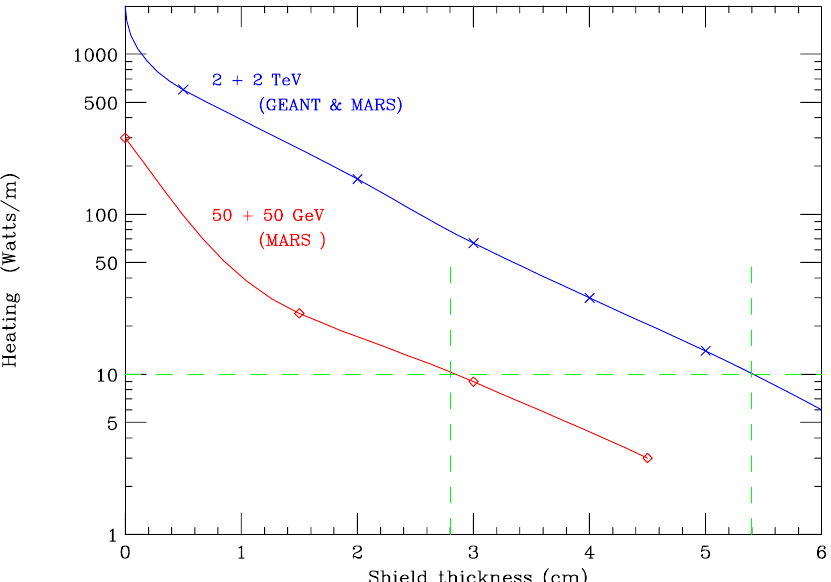
FIG. 53. (Color) Power penetrating tungsten shields vs their thickness for (a) 4 TeV and (b) 0.1 TeV colliders.